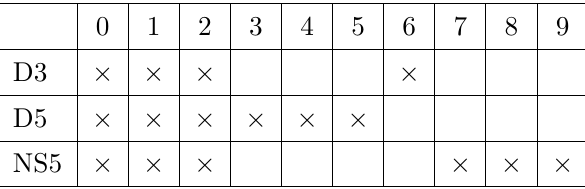
Table 6 . 1 -BPS intersection involving D3, D5 and NS5 branes. The intersection is SO(3) (cid:2) SO(3) 4 invariant due to rotational symmetry along ( x 3 ; x 4 ; x 5 ) and ( x 7 ; x 8 ; x 9 ). An AdS 4 vacuum with the same isometries emerges in the near horizon